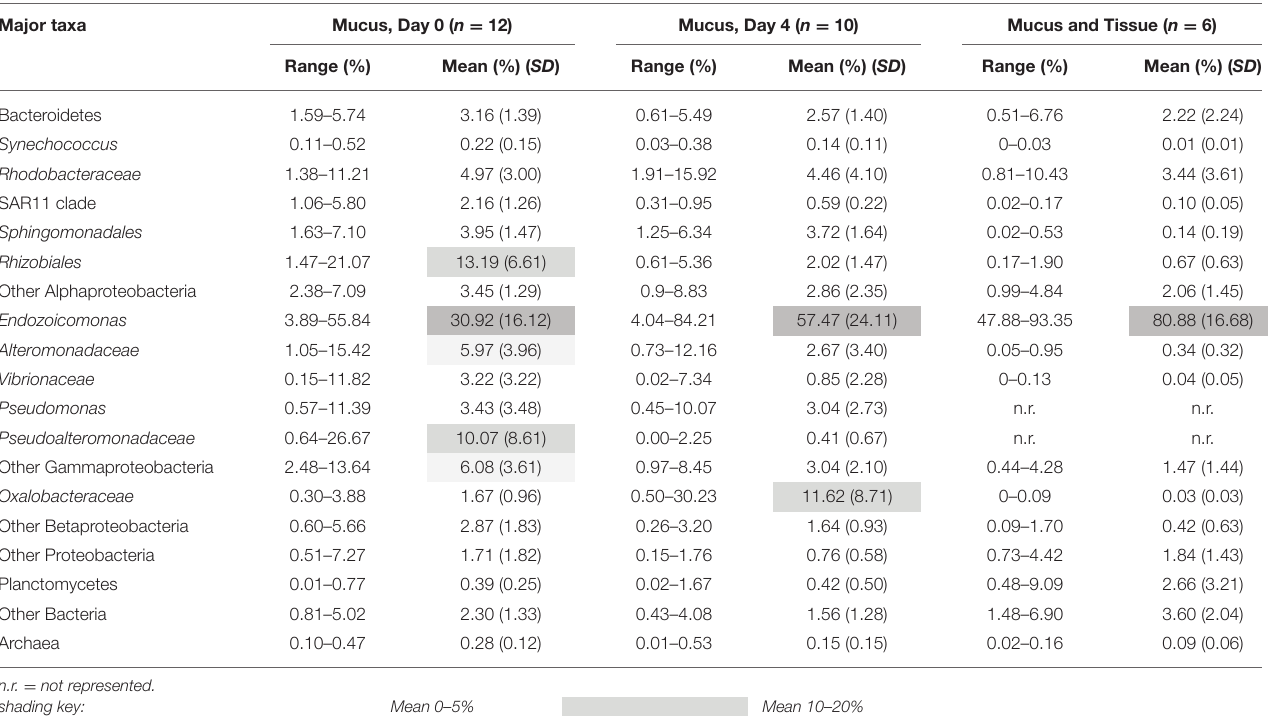
TABLE 3 | Percent composition of major bacterial and archaeal taxa represented in coral colonies ( SD = standard deviation). Major taxa